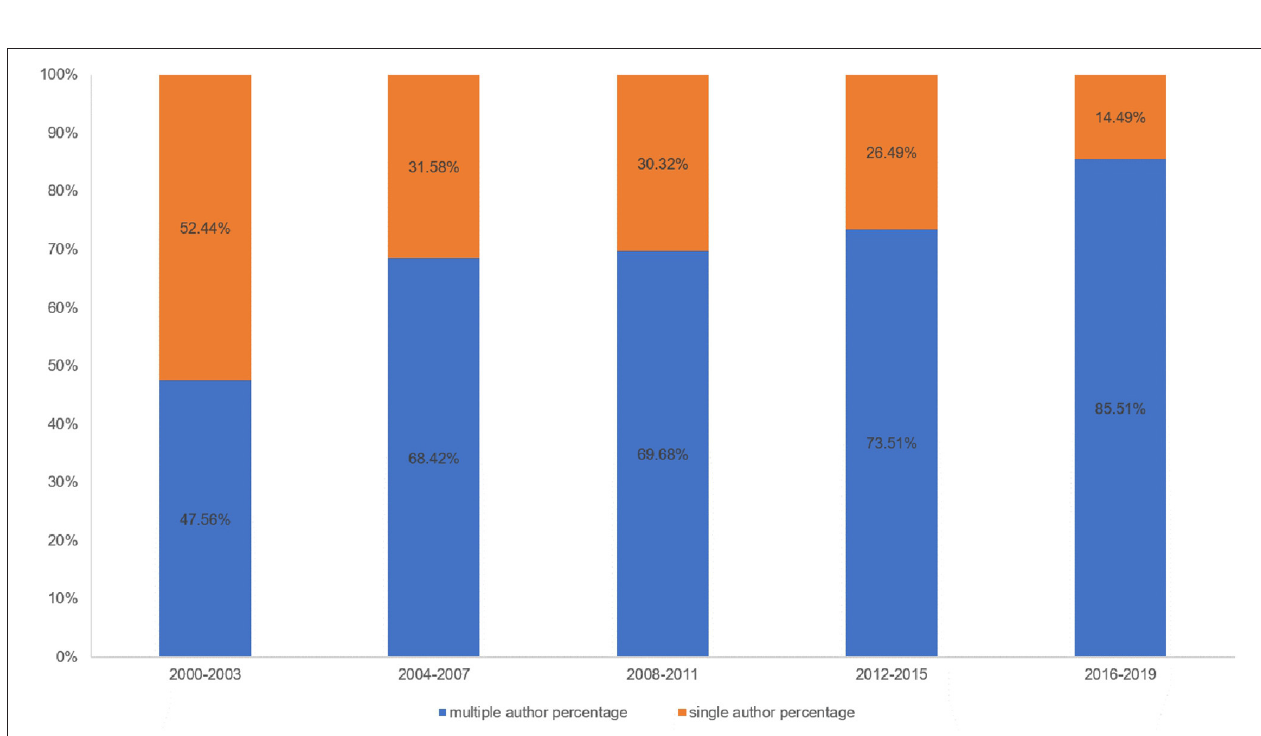
FIGURE 11 | The percentage of single- vs. multiple-authored articles. Blue bars mean multiple-author percentage; orange bars mean single-author percentage.